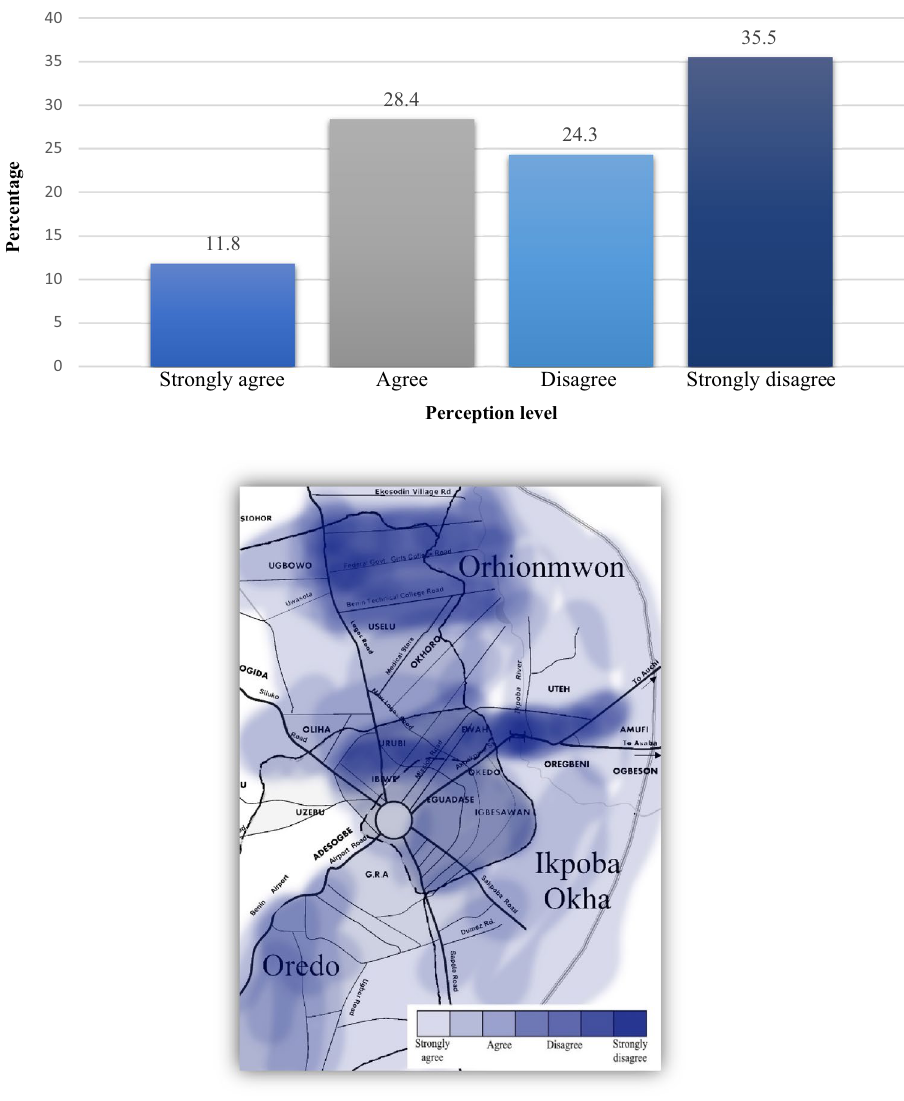
Figure 3. Perception that waste management can reduce the global effect of GHG emissions: (top) graph, (bottom) mapped